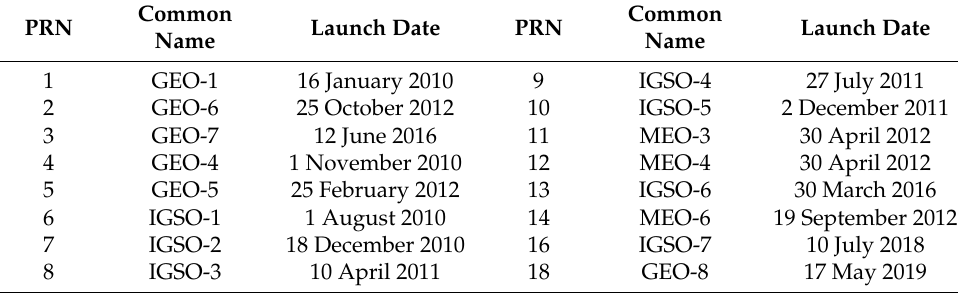
Table 1. Status of healthy BDS2 satellites (as of June 2020). PRN